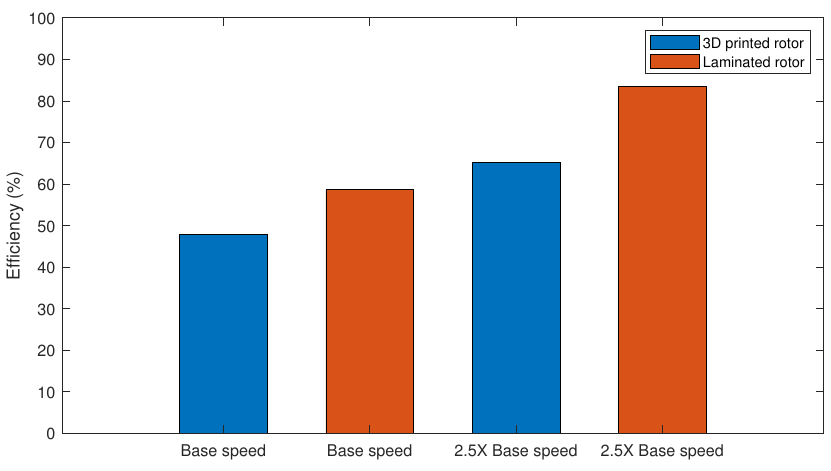
Figure 5. Illustration of eddy current loss impacts on efficiency of 3D printed electrical machine. Figures are adapted from